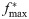
Quality control engenders a trade-off between folding accuracy, speed, and energy.(A) Shaded regions in the phase diagram represent all combinations of folding fraction f and total steady-state unfolded protein Punfolded that can be achieved by varying cycle parameters kc, k-c, kr, k-r, kg, k-g, and kd while keeping a fixed folding rate kf, production rate kpt, misfolded fraction mf, and background protein concentration Pb. Solid lines represent the maximal achievable folding fraction fmax. Dots represent the efficiency metric fmax*. (B) Each curve adjusts kc, k-c, kr, k-r, kg, k-g, and kd to maximize the folding fraction (Eq 2) while the total cycle energy (Eq 3) is varied and the total unfolded protein Punfolded=Pg+Pg*+Pc+Pc*+P+P* is constrained to equal one. Each curve shows a distinct level of background proteins Pb, with fixed kpt = 0.1, kf = 0.1, and mf = 0.001 for all curves.